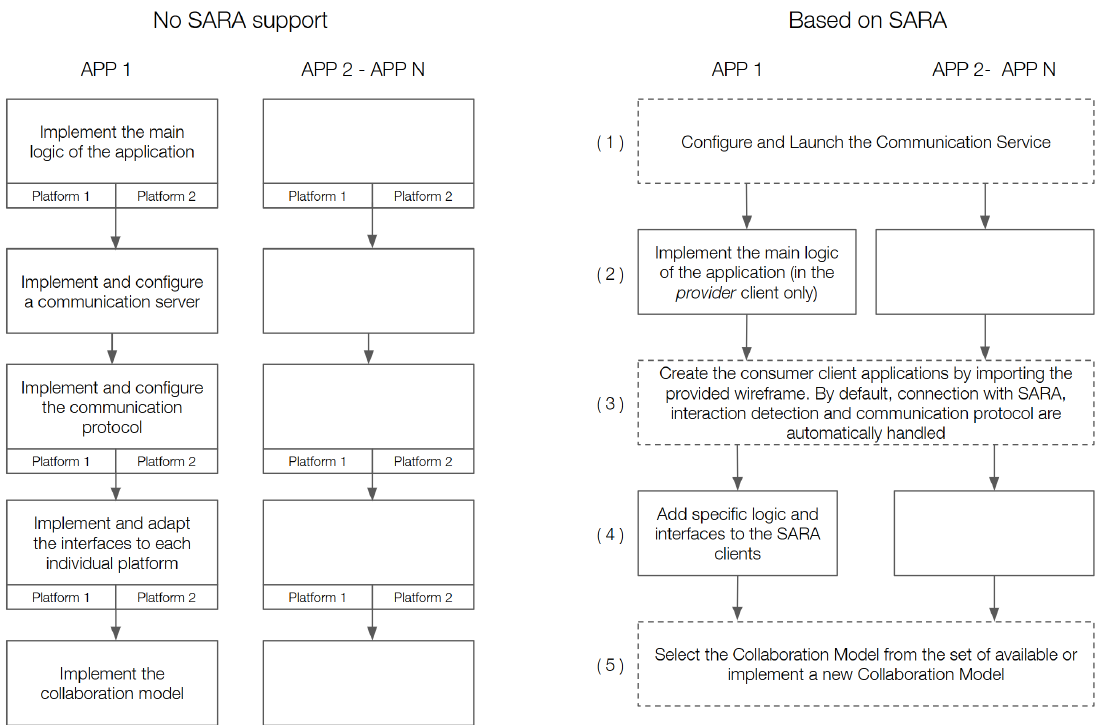
Figure 6. Sequence diagram that illustrates the communication between users and the Communication Service